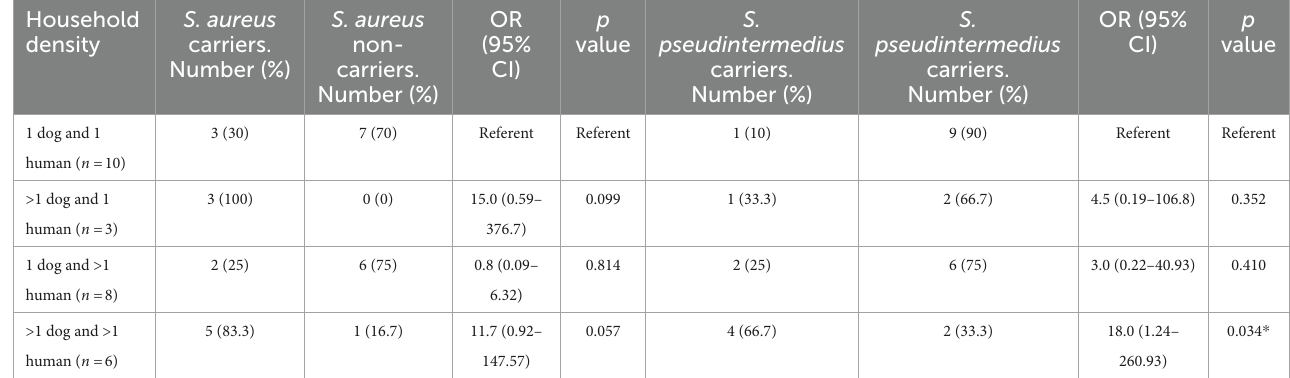
(Table 4). All the S. aureus isolates were negative for lukS/F -PV , tst-1, eta and etb genes (Table 2). However, all the S. pseudintermedius isolates were positive for lukS/F-I, siet, and sient virulence genes, but one was only sient -positive (Tables 2, 3).